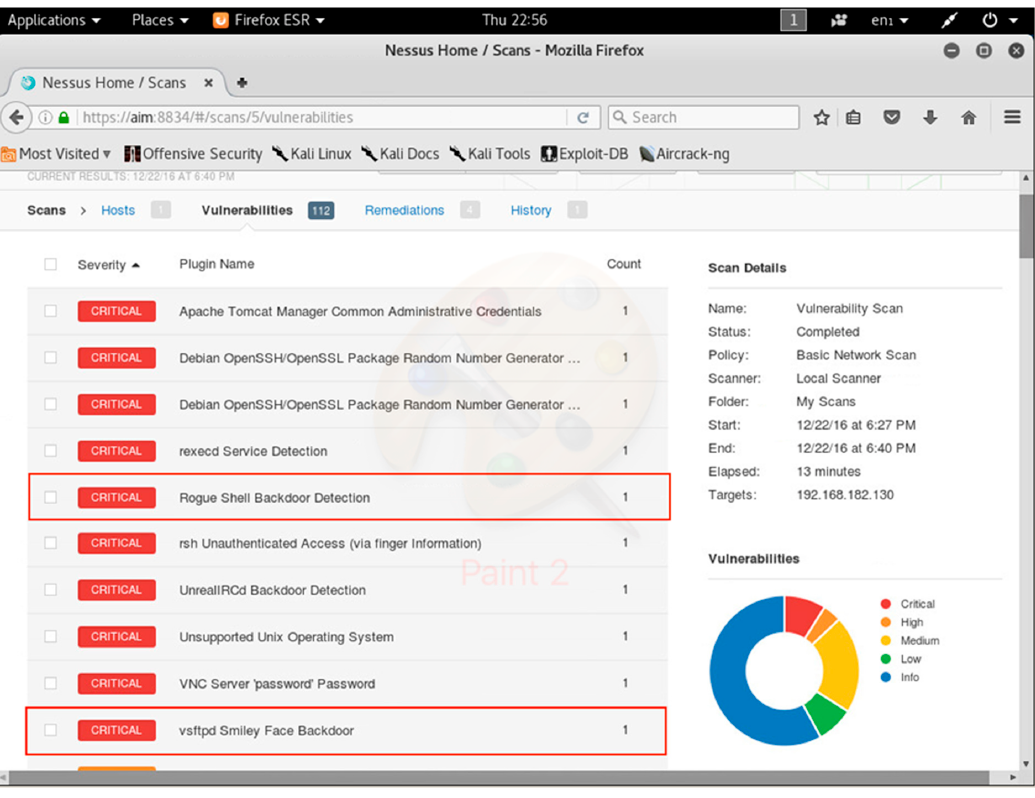
Figure 6. Output of Nessus Vulnerability Scanner.